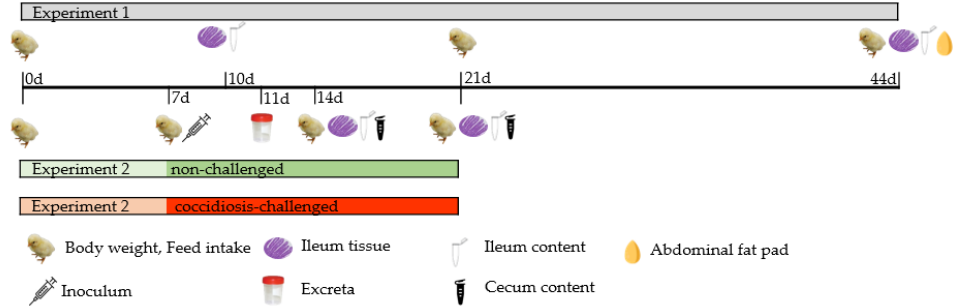
Figure 1. Sampling timeline. The figure shows the controls and sampling of Experiment 1 and Ex ‐ periment